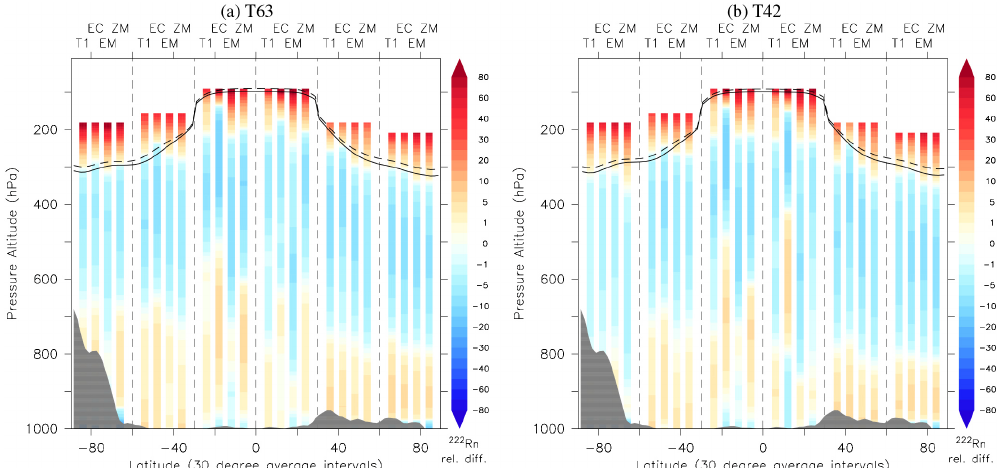
Figure 7. Zonally averaged relative change in radon ratios in the 2 × CO2 simulation. The vertical axis depicts the pressure altitude and each bar represents an average over 30 ◦ latitude (90 ◦ S to 60 ◦ S, 60 ◦ S to 30 ◦ S, etc.) for all simulations indicated in the top row of the graphs. The black solid (dashed) line illustrates the mean tropopause height of the REF (2 × CO2 ) simulations and the grey shaded area the zonal mean